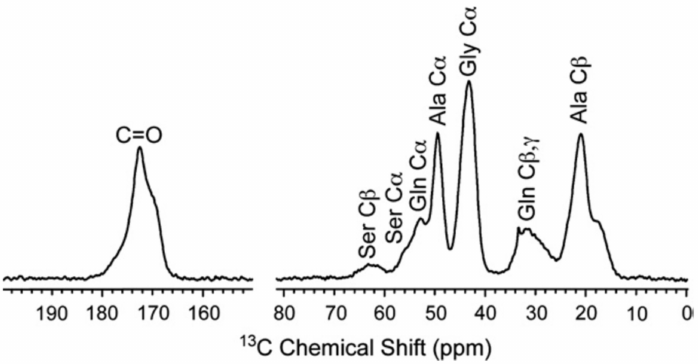
Figure 2. 13 C CP / MAS NMR spectrum of dragline silk fiber from N. clavipes spider together with the assignment [26]. The chemical shifts are represented from tetramethylsilane